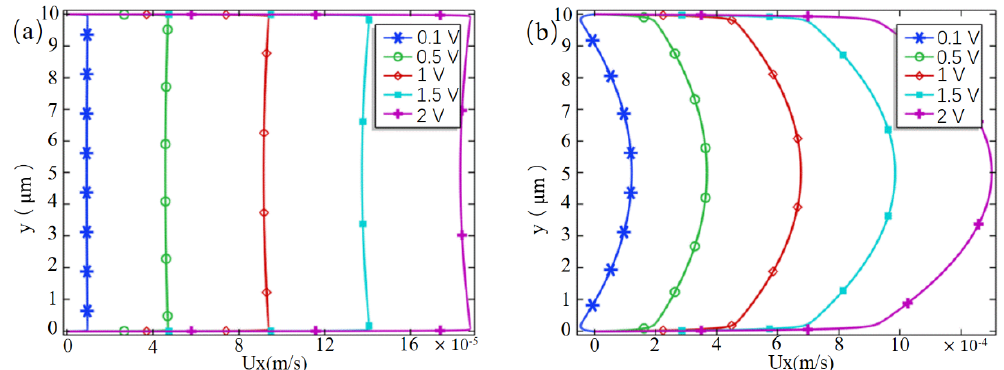
Figure 7. ( a ) Tangential velocity distribution of the cross section of the channel at x = 90 µ m when V cm = 0 mV; ( b ) tangential velocity distribution of the cross section of the channel at x = 90 µ m when V cm = 400 mV.